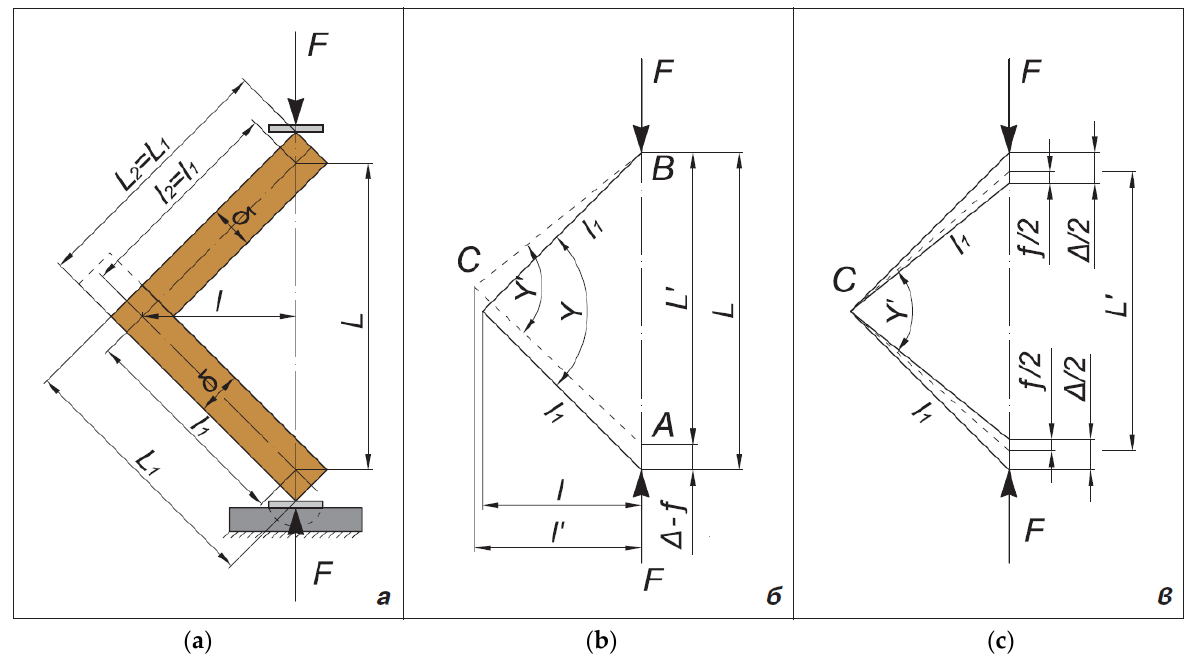
Figure 7. Test scheme and deformation under arm compression bending load of the test samples of end corner joints made of lightweight panels. Reprinted with permission from Ref. [11]. 2021 BISMAR. ( a ) Type of loading and dimensions of the tested samples; ( b ) scheme of loading and determination of the deformation of the tested samples.